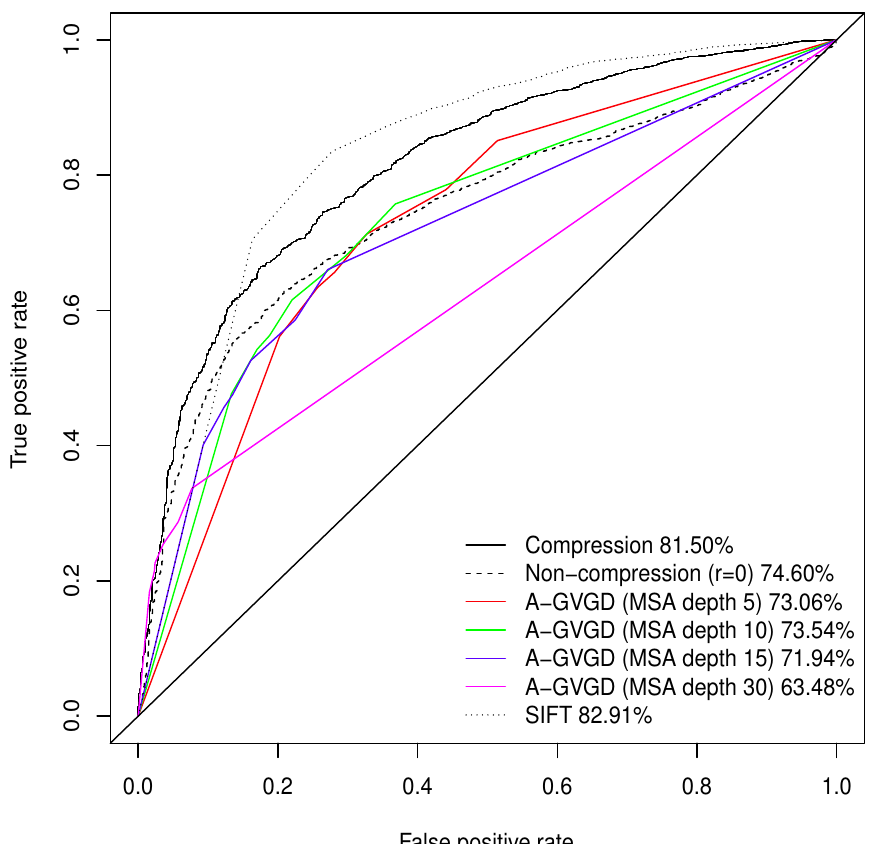
Figure 1. Receiver Operating Characteristic for various classification algorithms. GM clustering (full MSA depth) with compression-adjusted GV and without compression-adjustment. Align-GVGD with MSA of various depths. Respective AUC displayed as percentage in legend. The progressively deeper MSAs display higher propensities to simultaneously low true and false positive rates, classifying all variants as neutral, in keeping with the findings of Hicks et al . [5]. SIFT performed marginally better than compression-adjusted GM , but it did not assign a classification to 4.29% of the